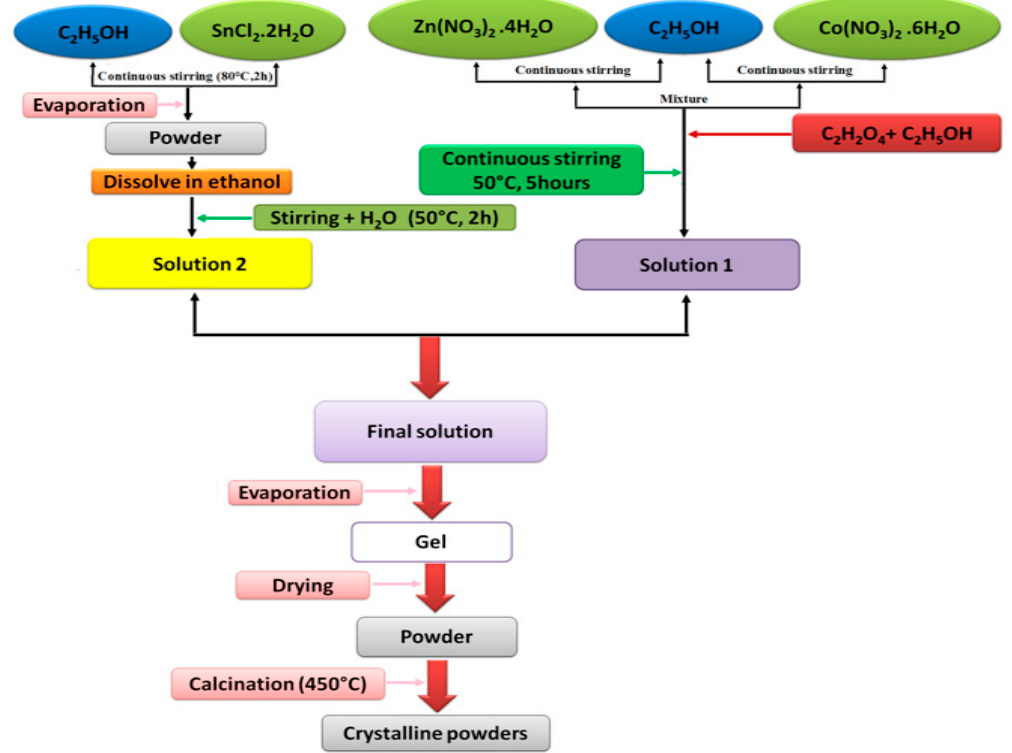
Figure 14. Process for sol-gel synthesis of ZnCo 2 O 4 and SnO 2 loaded ZnCo 2 O 4 .